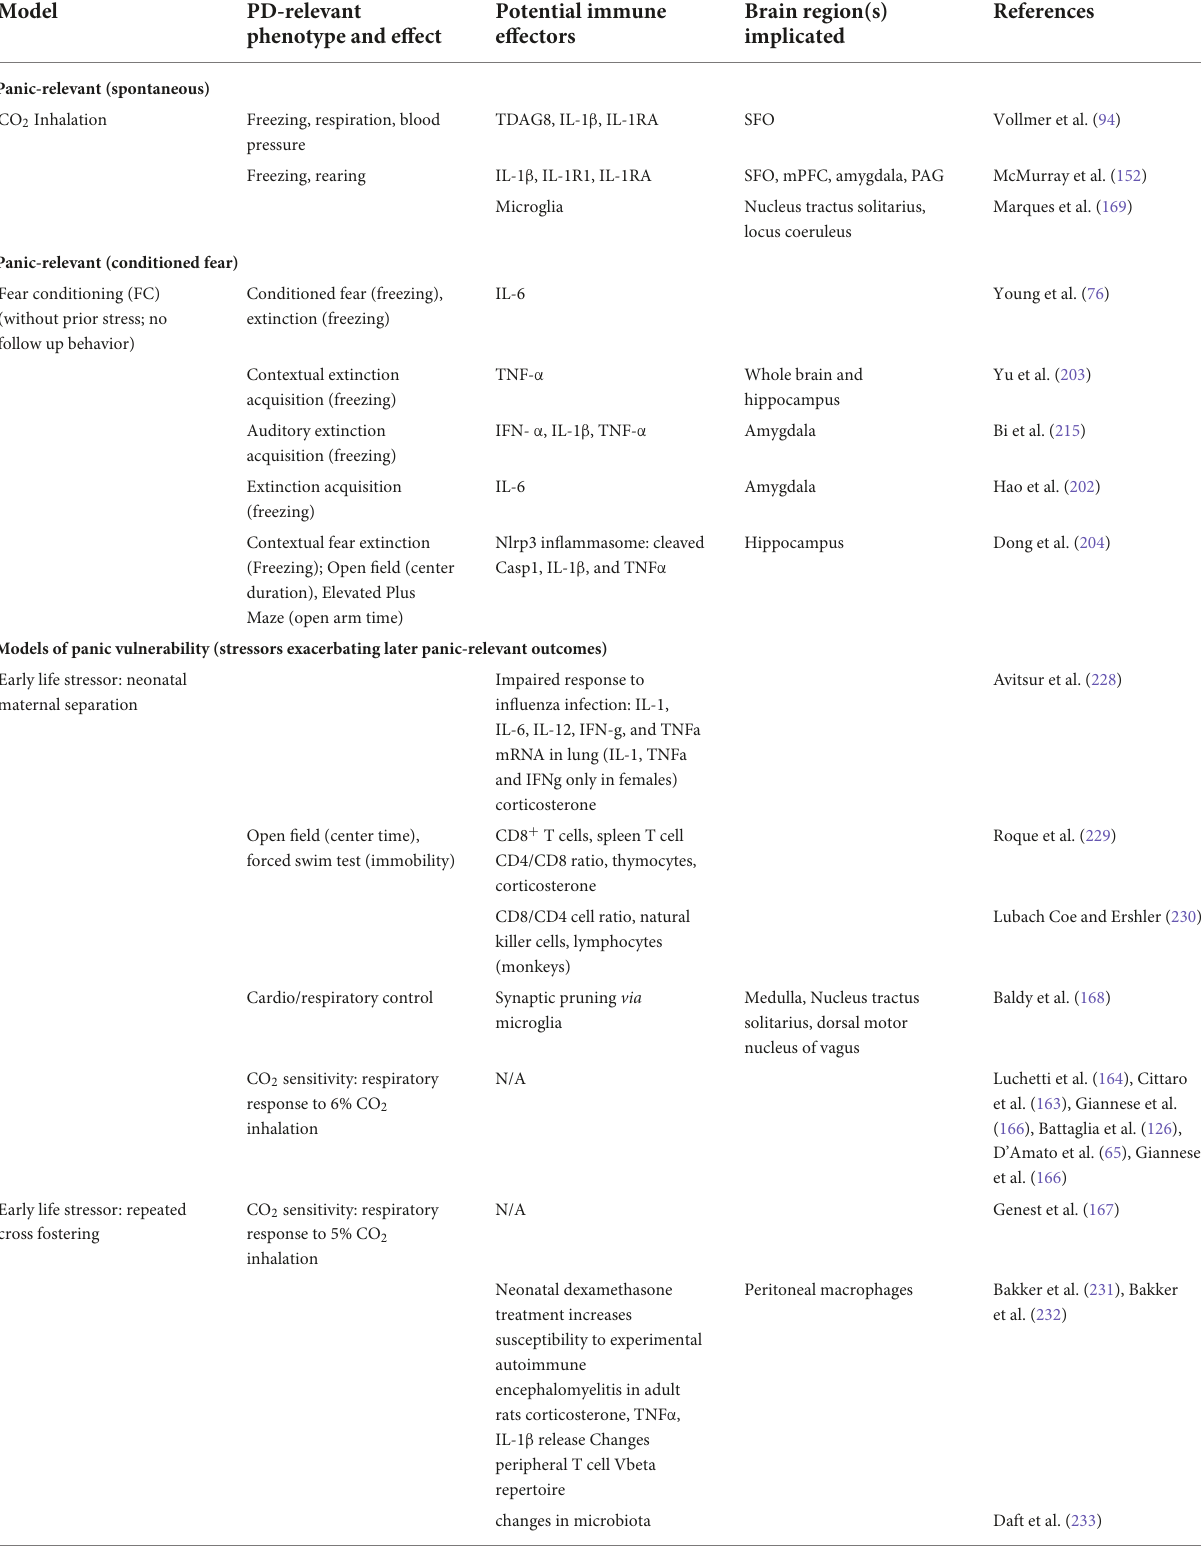
TABLE 1 Animal studies of immune regulation of spontaneous/conditioned